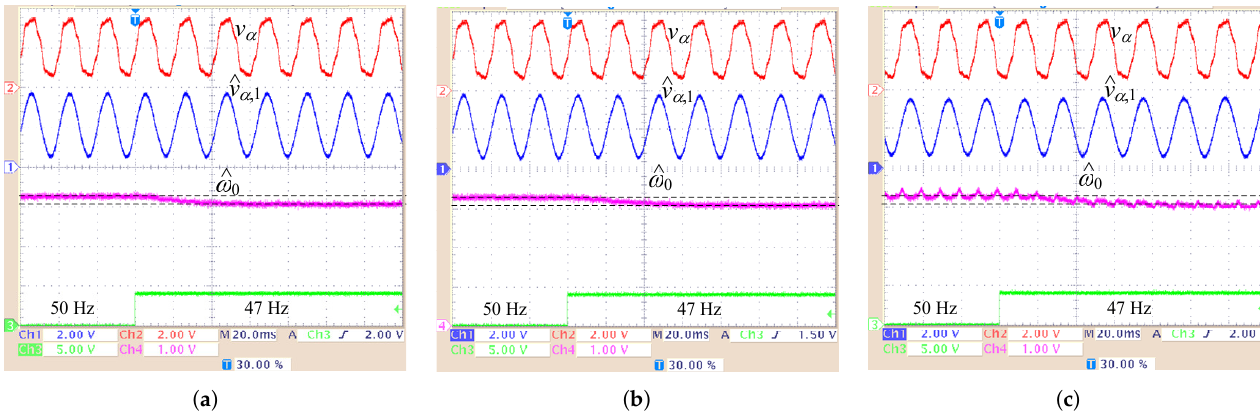
Figure 10. Transient responses after a step change in the fundamental frequency f 0 from 50 Hz to 47 Hz for: ( a ) the SOHO-based FLL, ( b ) the SOGI-based FLL, and ( c ) the SRF-based PLL. ( top ) v α , ˆ v α ,1 ( x -axis: 10 ms/div; y -axis: 400 V/div) ( middle ) ˆ ω 0 ( x -axis 10 ms/div; y -axis 97.66 rad/s/div) and ( bottom ) step-change enable signal.